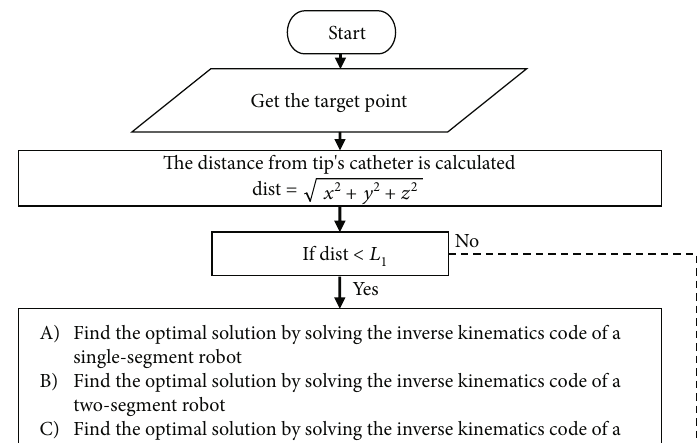
Figure 12: Three-segment catheter workspace in 3D.